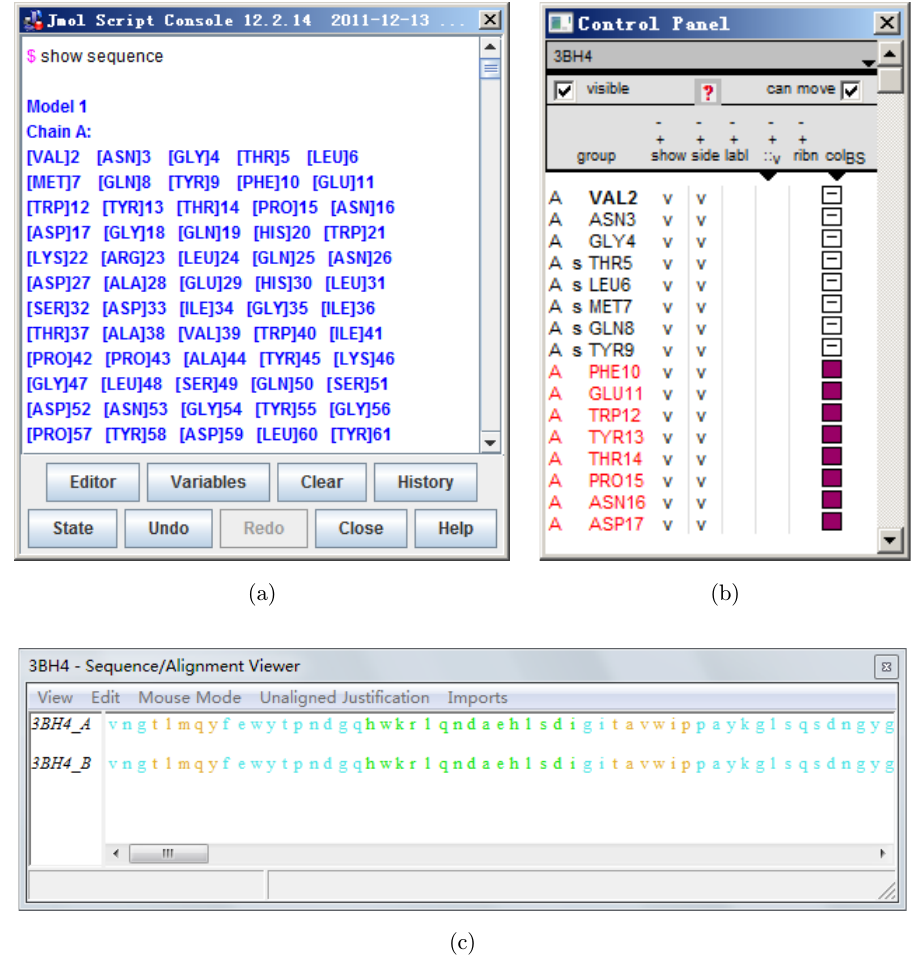
Fig. 2. Sequence reference features in three traditional molecular 3D visualization tools. (a) Sequence information display in the console window of Jmol 12.2.14. (b) Control panel of Swiss-PdbViewer 4.1.0. (c) Sequence/Alignment Viewer of Cn3D